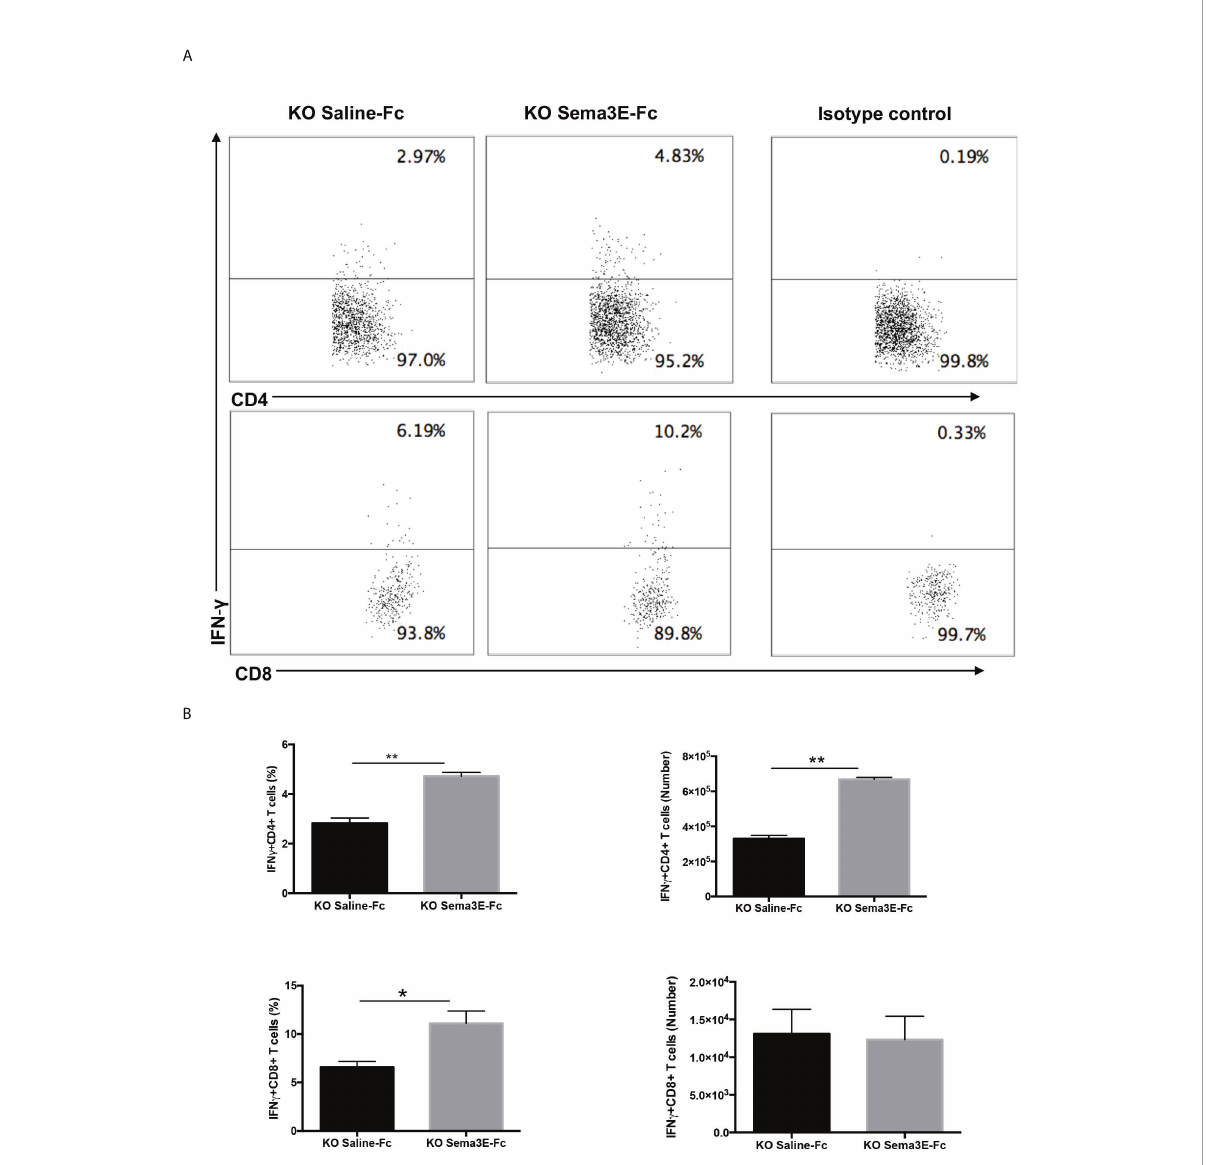
FIGURE 4 Higher IFN- g production by CD4 and CD8 T cells after Sema3E-Fc treatment of Cm infected Sema3E KO mice. CD4 + and CD8 + T cells isolated from the lungs of Cm infected mice at day 7 post-infection were stained intracellularly for IFN- g . (A) Representative fl ow cytometric images and summary of fl ow cytometric analysis (B) to show the percentage and absolute number of IFN- g producing CD4 and CD8 T cells. Data are shown as mean ± SD (n = 3) and represent one of three independent experiments with similar results. * p < 0.05, ** p <